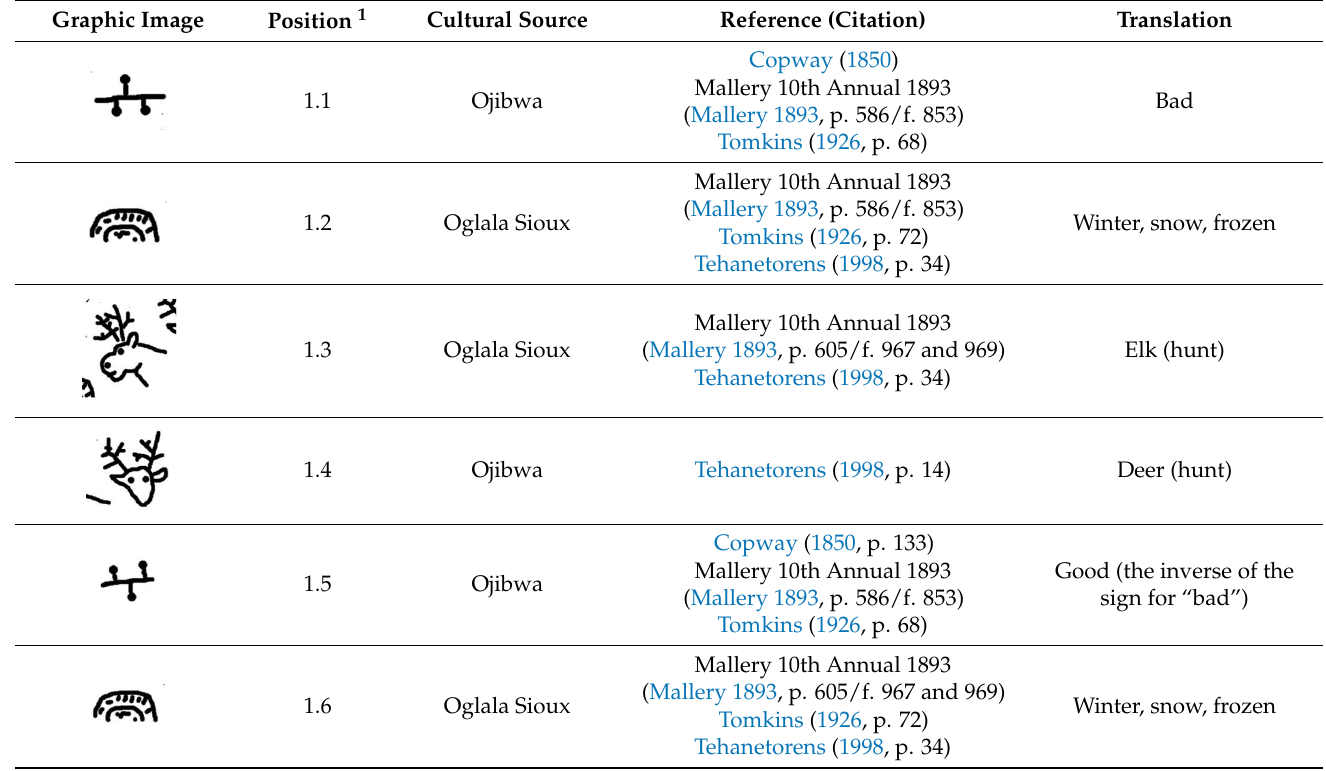
Table A1. Source material for the transliteration of panel 2 at Green River WY.